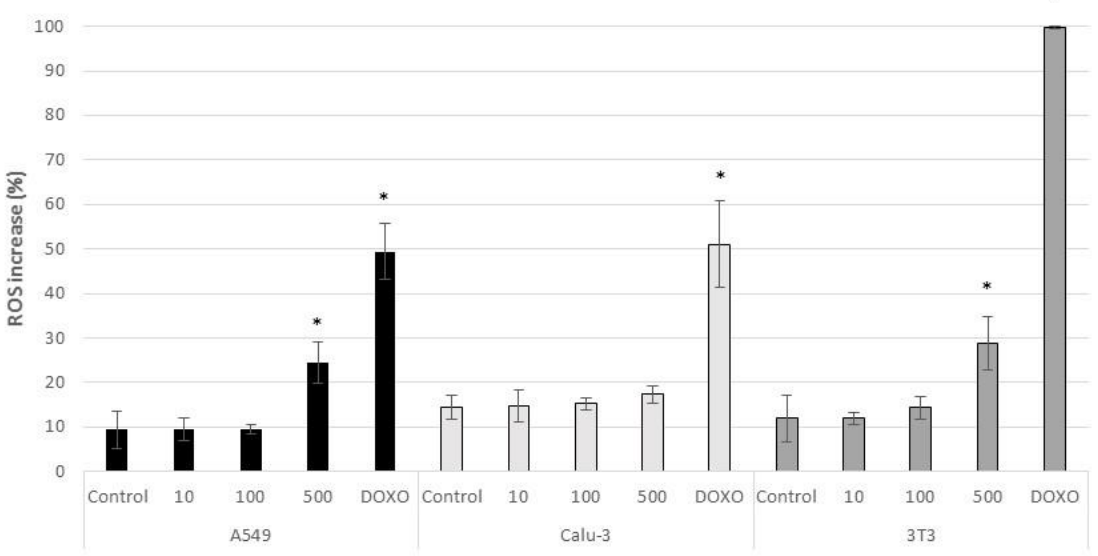
Figure 8. ROS production in control A549, Calu-3, and 3T3 cells and in cells exposed for 24 h to CeO 2 -NPs (10, 100, and 500 µg/mL), and to the positive control Doxorubicin. Results are expressed as means ± SD of six replicates per tested condition and three independent assays ( n = 18). Asterisks indicate significant differences with respect to the untreated control cells ( p < 0.05).